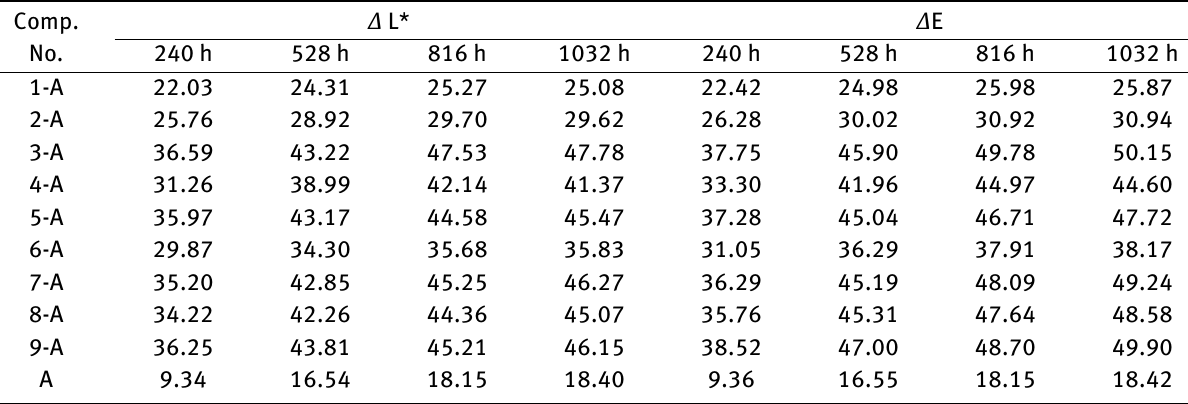
Table 2: Colour parameters of all WPCs composites at the different weathering time. Comp.